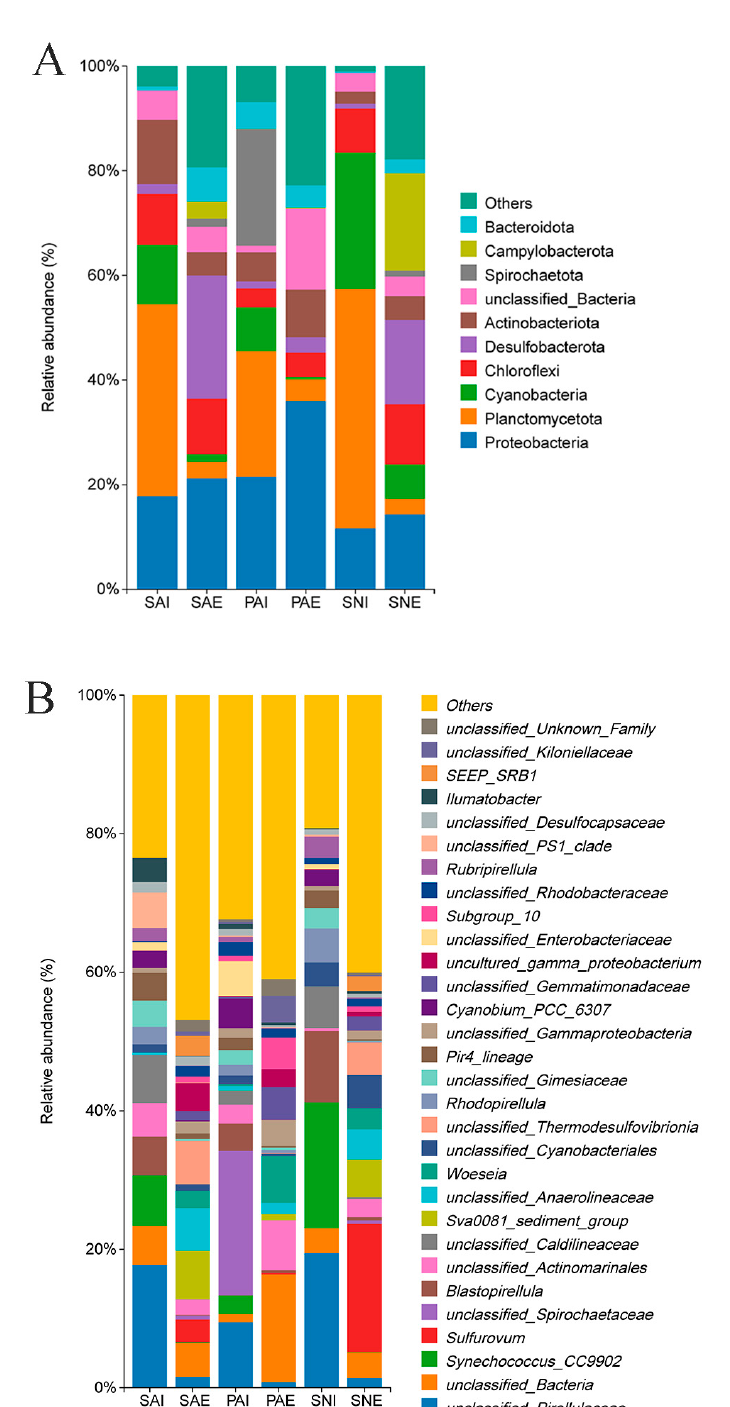
Figure 3. Relative abundances of bacterial communities at the phylum ( A ) and genus ( B ) level of the different groups. The gut contents and surrounding sediments of S. australe, P. arcuatum, and S. nudus are, respectively, marked as SAI, PAI, SNI, SAE, PAE, and SNE.